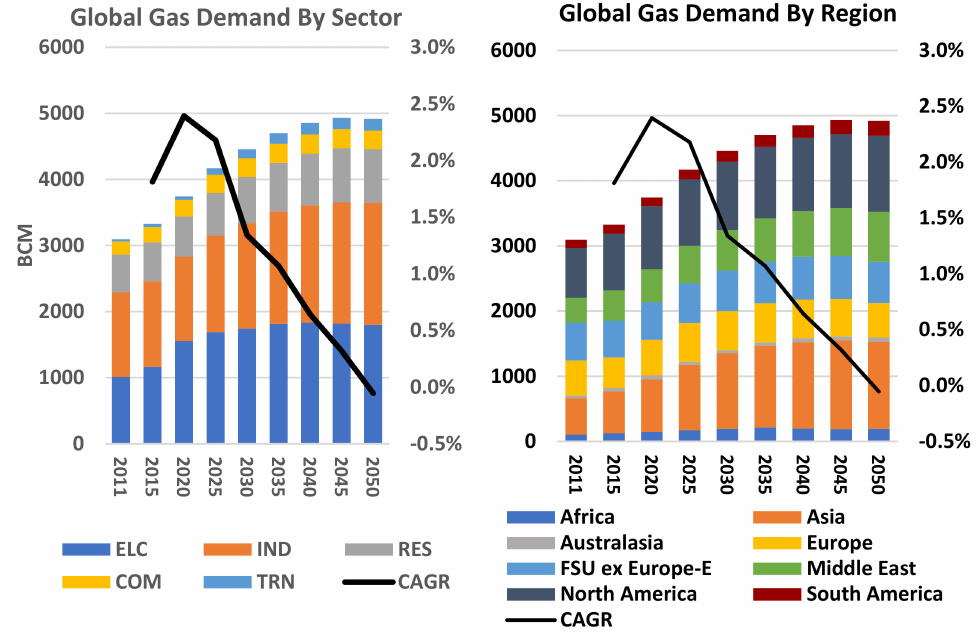
Figure 15. Global gas balance by sector and by